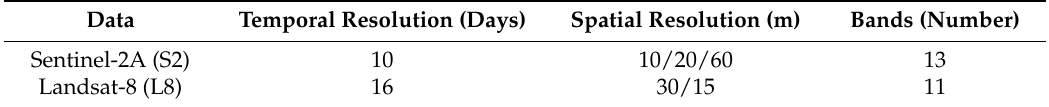
Table 1. Basic description of